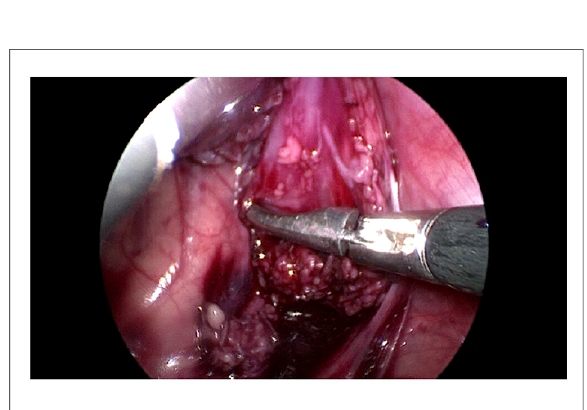
FIGURE 5 Group B: only the posterior part of the rectum was mobilized in a retrorectal avascular plane.